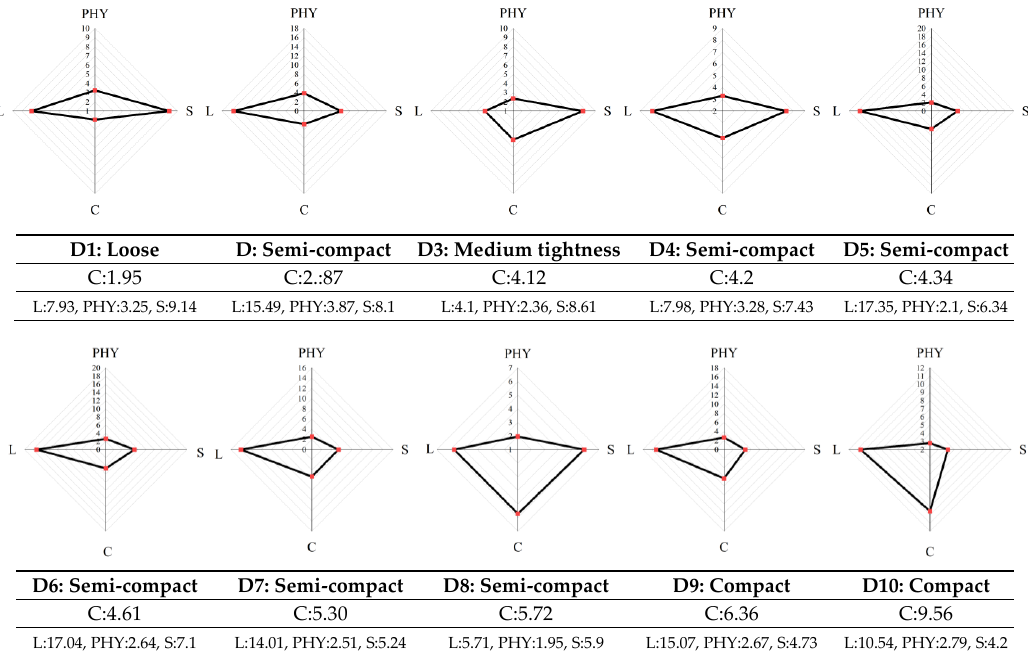
Figure 7. Quantitative plant architecture